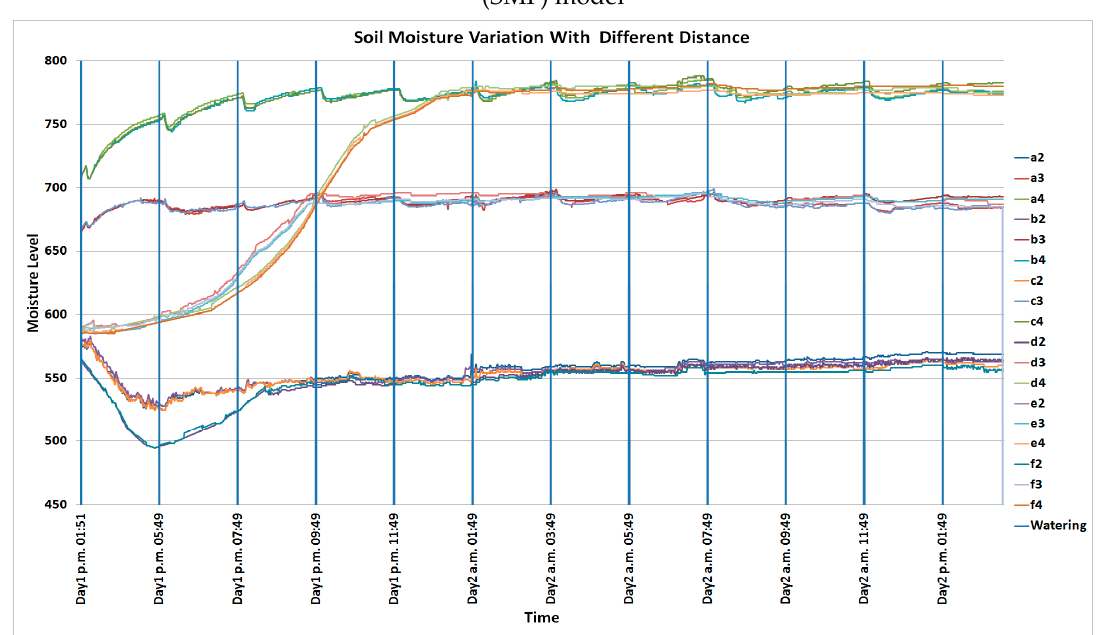
Figure 4. Data gathering scenario for building the SMF model. The locations {a, b, c} and {d, e, f} are 3 cm and 6 cm to the irrigating point, respectively. The dimension of moisture levels is 0–1023. ( a ) The soil sensors for collecting data in the SMF model are installed around the watering point with three directions. The distances of the sensor in different directions are the same. ( b ) The moisture variation of the six installed sensors with different depth layers. The moisture values of the sensors located at 6 cm to the watering point do not have an explicit reaction.